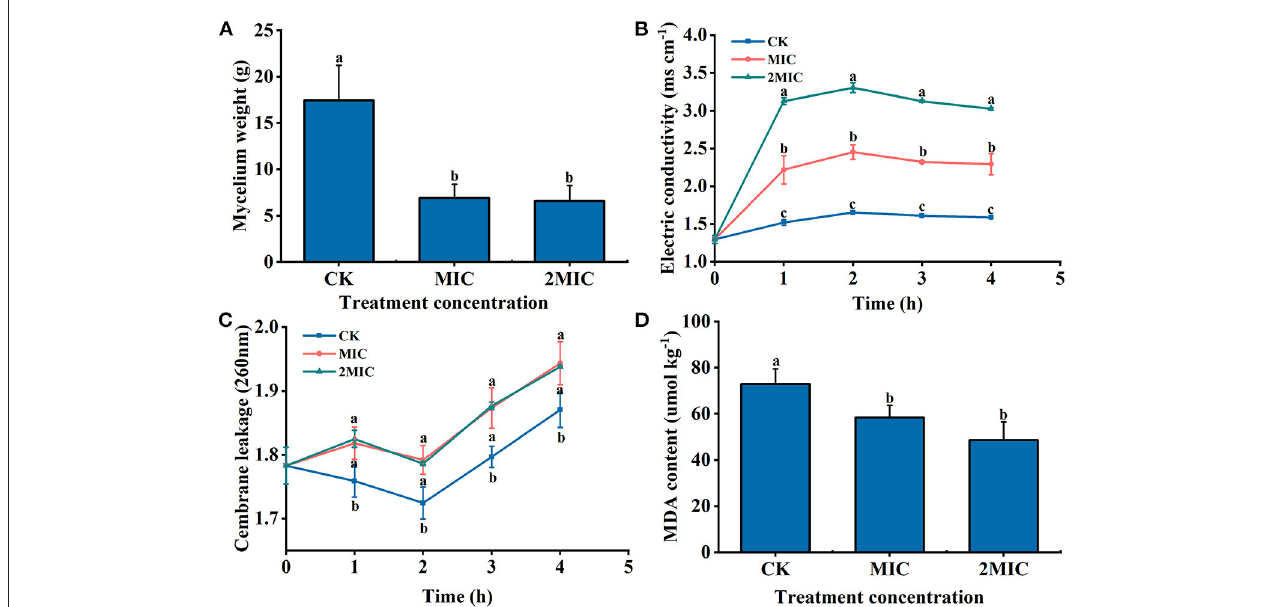
FIGURE 3 | B . dothidea treated by NaHS [minimum inhibitory concentration (MIC), 2MIC]. (A) Mycelial weight; (B) extracellular conductivity; (C) the absorbance value of extracellular fluid at 260nm; and (D) the content of malondialdehyde (MDA). Vertical bars represent the standard errors. Letters indicate significant differences ( P <